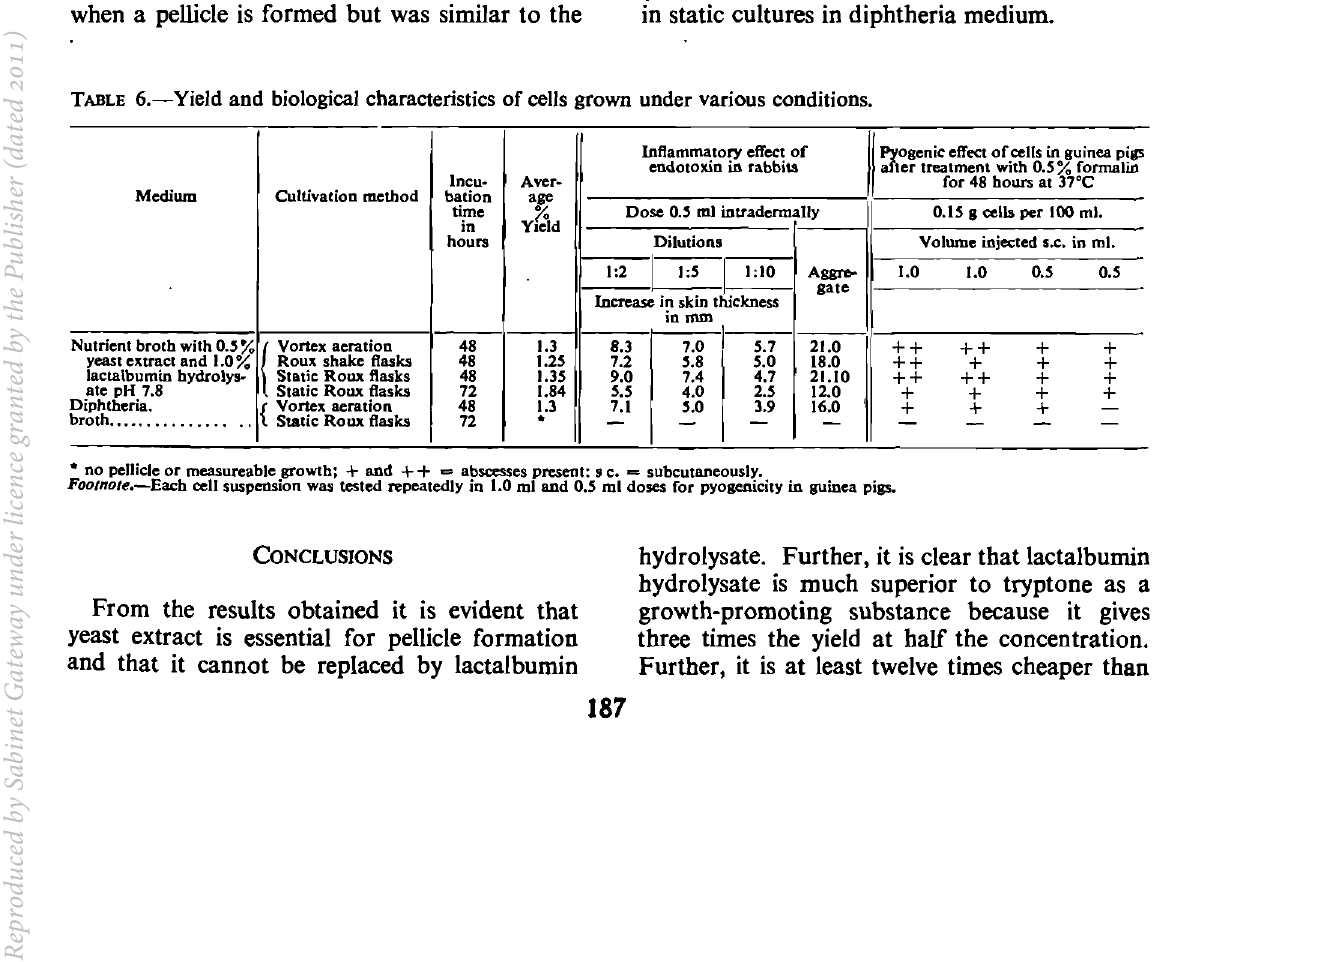
TABLE 6.-Yield and biological characteristics of cells grown under various